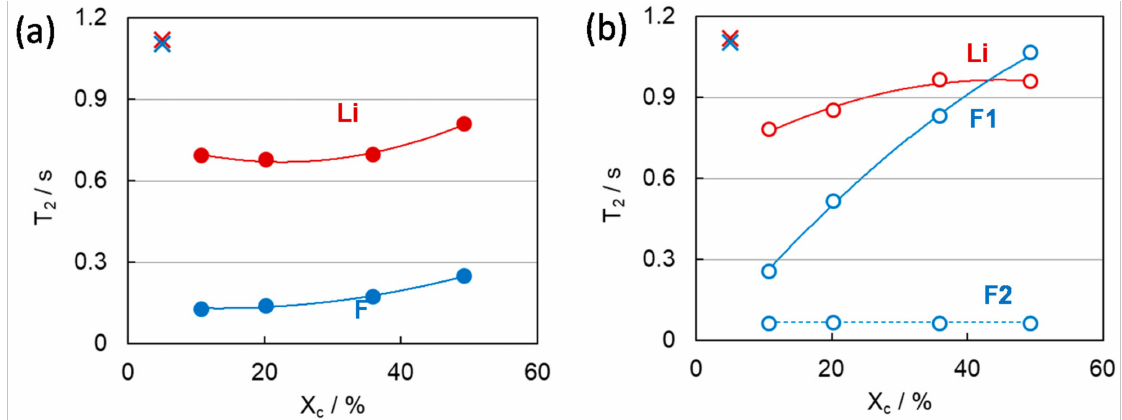
Figure 16. T 2 (Li) (red) and T 2 (F) (Blue) of the gels with 10 wt% of PVDF-based polymer and 90 wt% 1 M LiTFSI/PC prepared by ( a ) quenching and ( b ) annealing. F1 is the value of the major component (>80%), and F2 is the values of the minor component (<20%). × symbols represent the T 2 (Li) (red) and T 2 (F) (blue) of the free electrolyte solution without polymer. Reprinted with permission from [14]. Copyright 2020 ACS